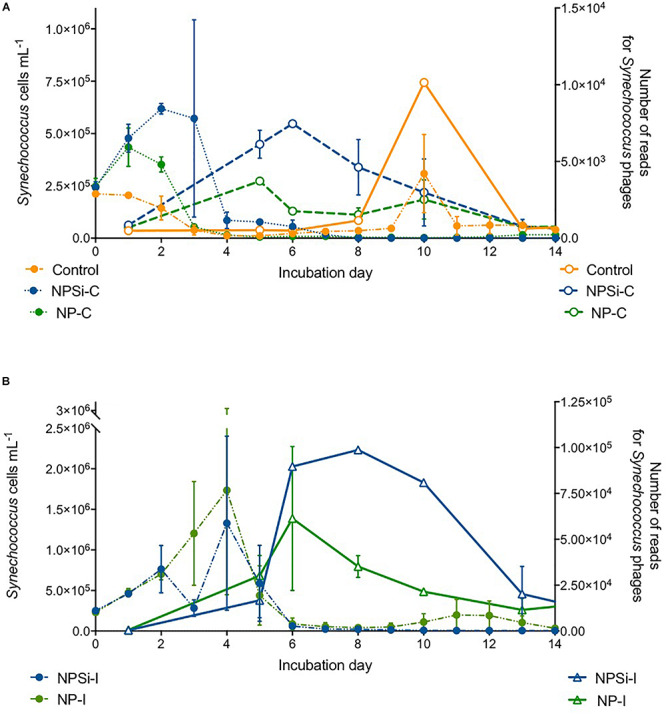
Comparison between the timing of Synechococcus cell abundances (cells mL–1) and number of Synechococcus phage reads along the experiment, estimated as mean values for the duplicate mesocosms (± standard errors), for the control and continuous treatments (A), and for the initial treatments (B).